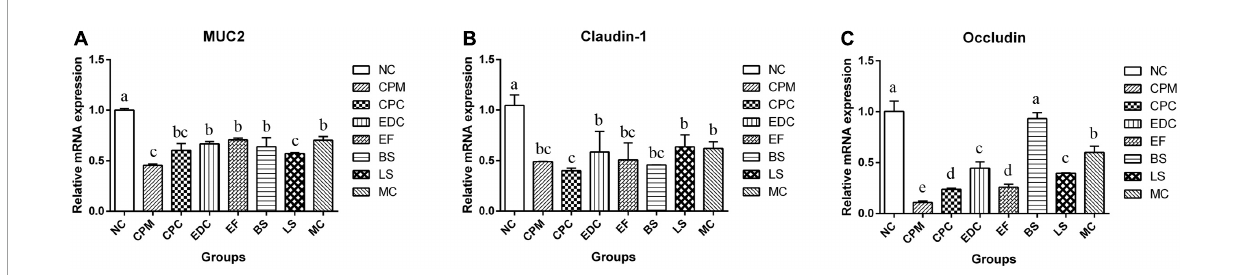
FIGURE6 Changes in mucins and tight junction proteins after different treatments ( n = 6). (A–C) The relative expression levels of Muc 2 , Claudin-1 and Occludin genes in the ileum were measured by qRT-PCR. Data represent mean values ± SEM. a-c Different letters indicate significant differences ( P < 0.05).